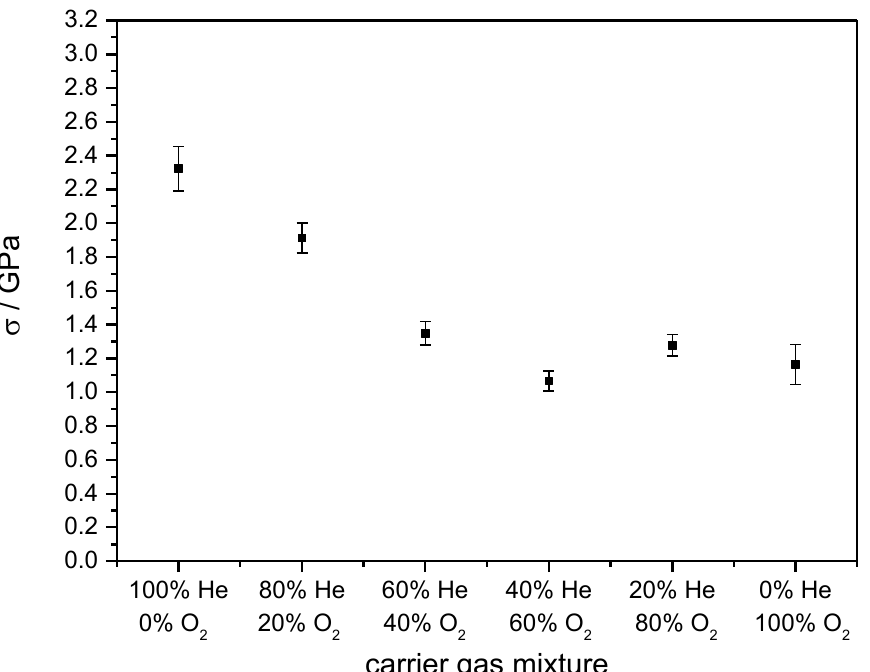
Figure 4. Film stress in dependence of He/O the calculation of errors of the used measurement